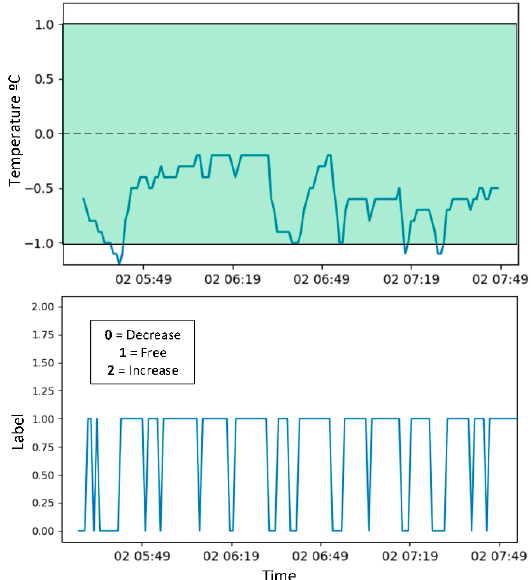
Figure 9. Detail of a specific S temperature with its corresponding assessment in each situation. The green area of the temperature plot represents the permissible temperature range.